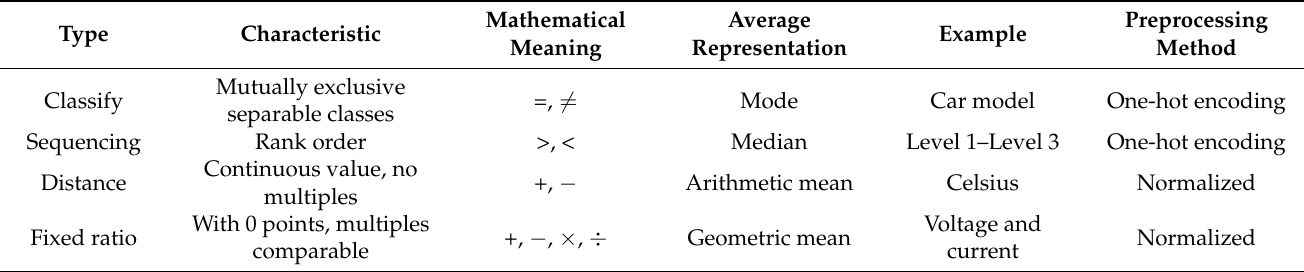
Table 2. Various data characteristics, examples, and preprocessing